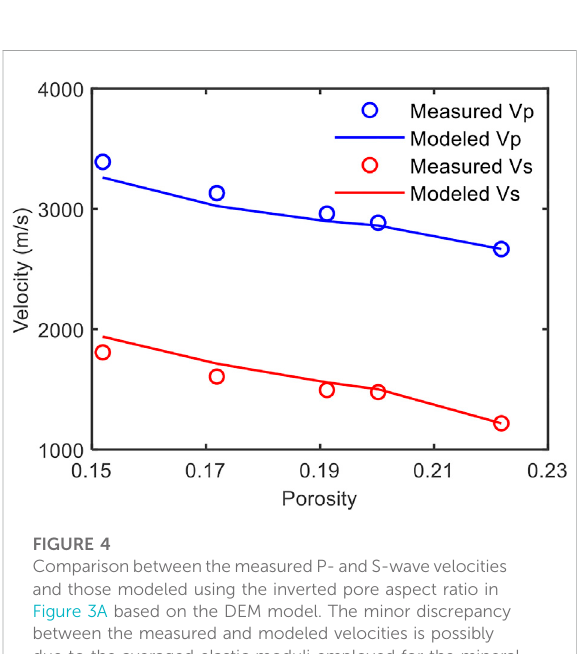
ComparisonbetweenthemeasuredP-andS-wavevelocities and those modeled using the inverted pore aspect ratio in Figure 3A based on the DEM model. The minor discrepancy between the measured and modeled velocities is possibly due to the averaged elastic moduli employed for the mineral